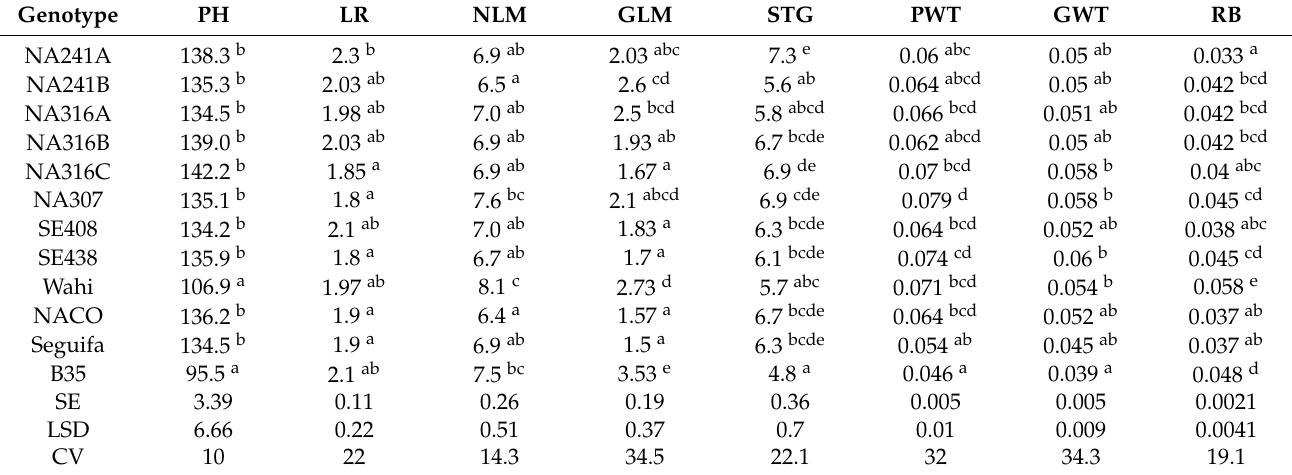
Table 6. Mean values of traits of sorghum genotypes under water-stressed